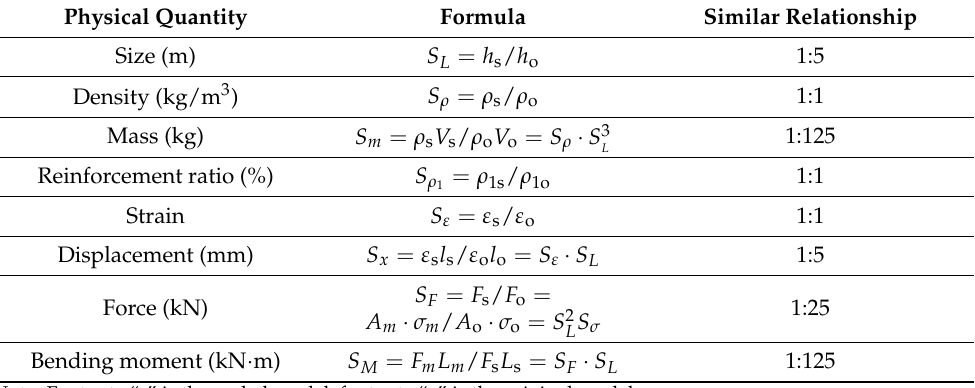
Table 2. Similar relationship.